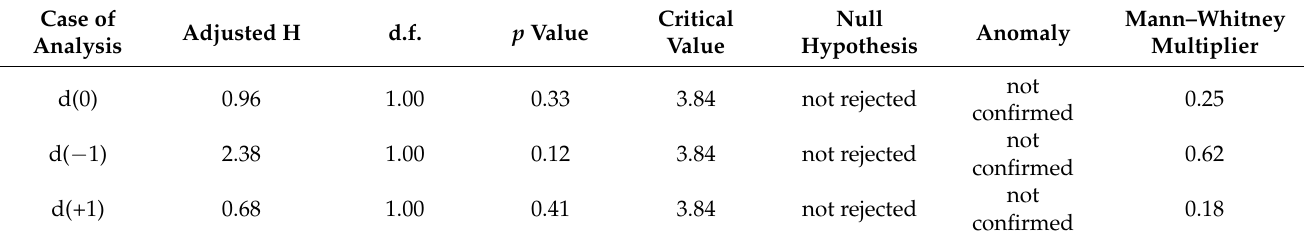
Table A3. Mann–Whitney test of the expiration day price effects.